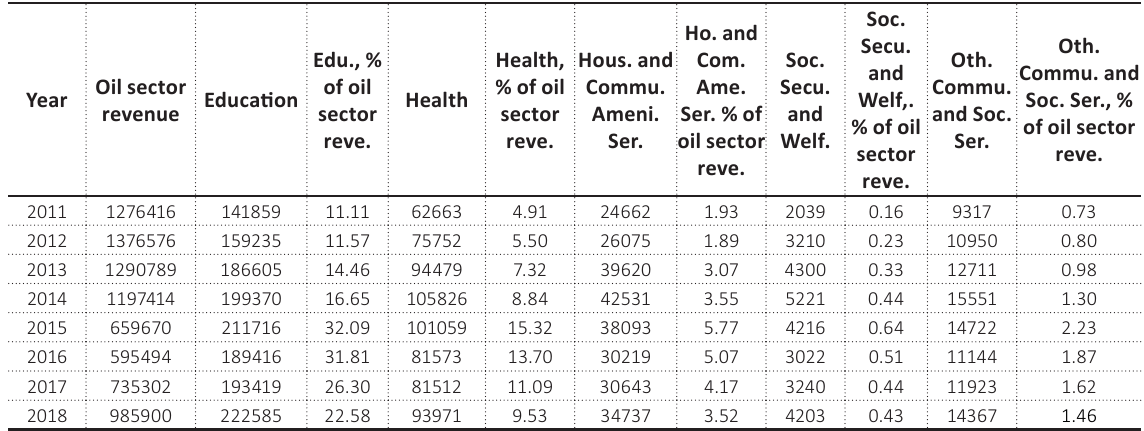
Source: Own calculations based on the values given in Table